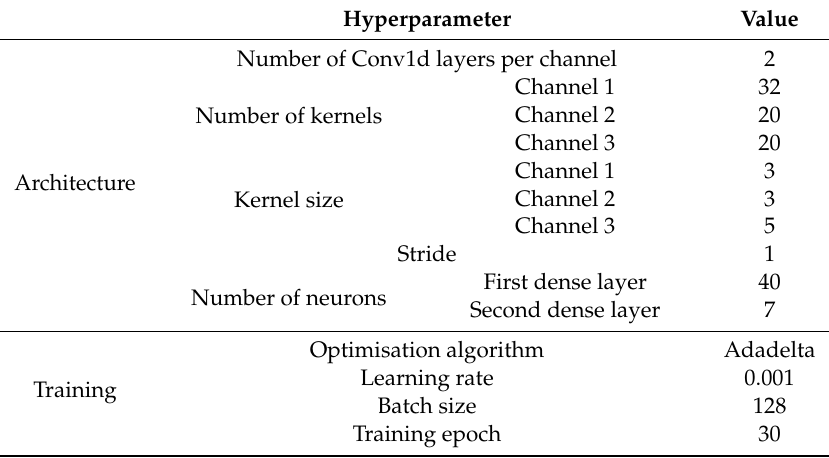
Table A3. Hyperparameter values for the multichannel